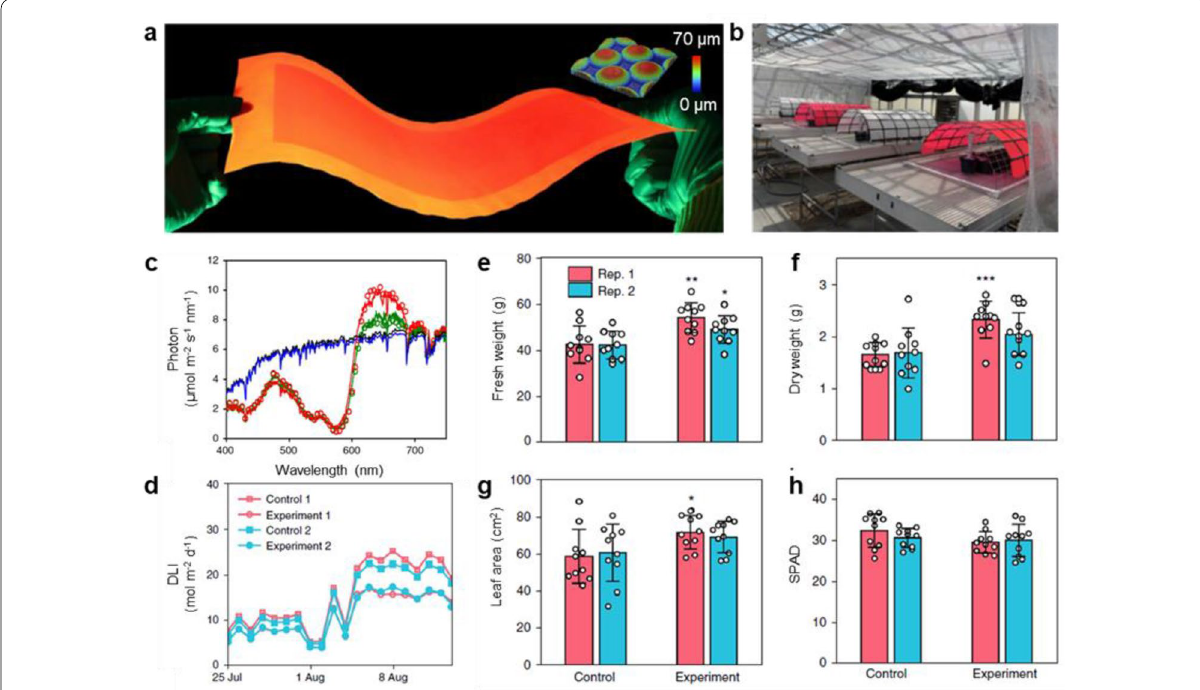
Fig. 4 a Photograph of a green-to-red spectral conversion film with micro-structures on the top surface under green light illumination. Inset is the surface topography of the micro-structures. b Photograph of the semicylindrical roof domes arranged in the greenhouse facility. c The forward spectral irradiance of the spectral conversion film with surface micro-structures (red curve), the fluorescent film without surface micro-structures (green curve), the planar fluorophore-free film (black curve), and the fluorophore-free film with surface micro-structures (blue curve) under the emulated solar irradiance. d DLI inside all four domes. e – h Aboveground fresh weight ( e ) and dry weight ( f ), average leaf area ( g ) and SPAD values ( h ) of the lettuces at day 20 after transplantation. Republished with permission from